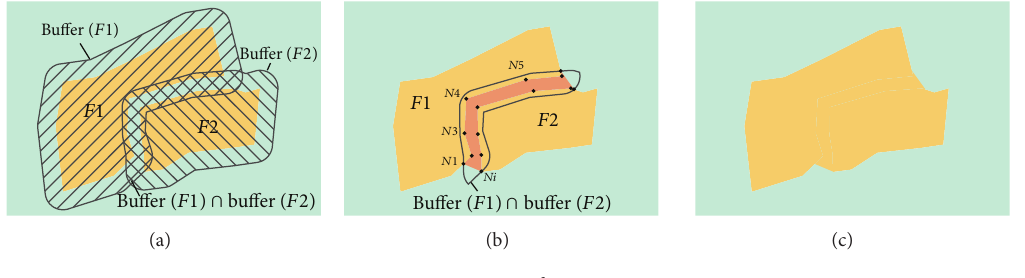
Figure 4: Process of